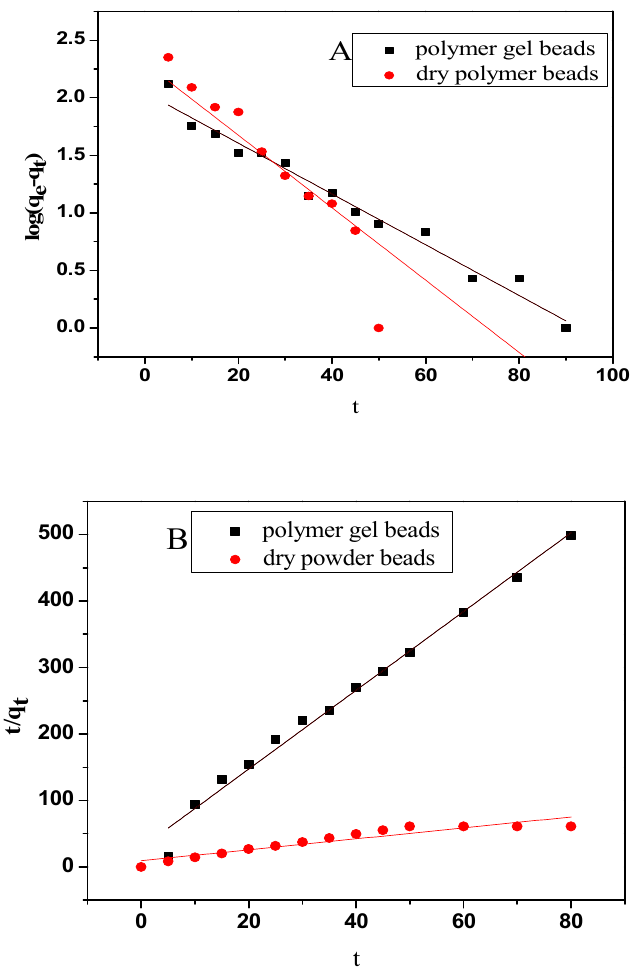
Figure 10. Adsorption of MB onto polymer gel beads and dry polymer beads fitted with the pseudo-first-order model ( A ) and the pseudo-second-order model ( B ). Table 4. Kinetic parameters for the adsorption of MB onFe 3 O 4 /AC/CD/Alg polymer gel beads and dry polymer beads.